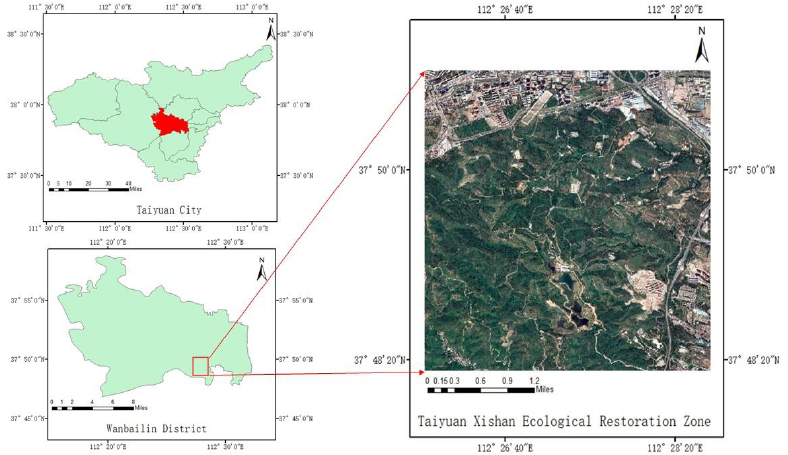
Figure 1. The study area.